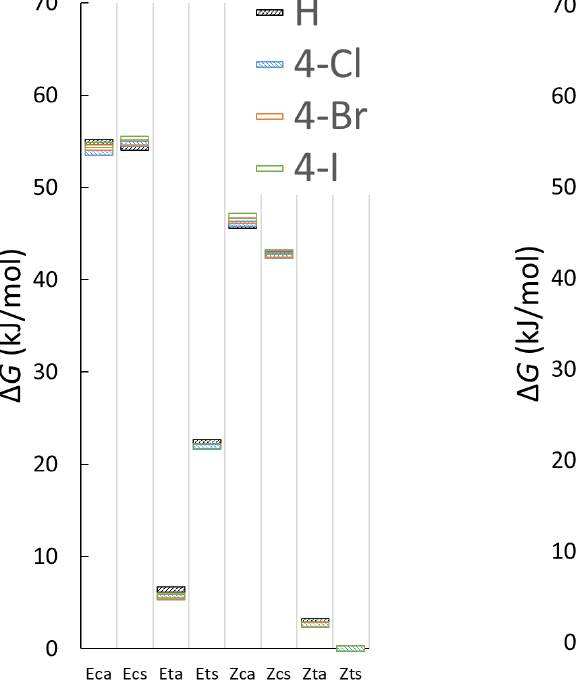
chlorohydrazones 1 – 7 , so the previous qualitative analysis of 1 also applies to 2 – 7 . The ∆ G between isomers changes by less than 5 kJ/mol upon halogen